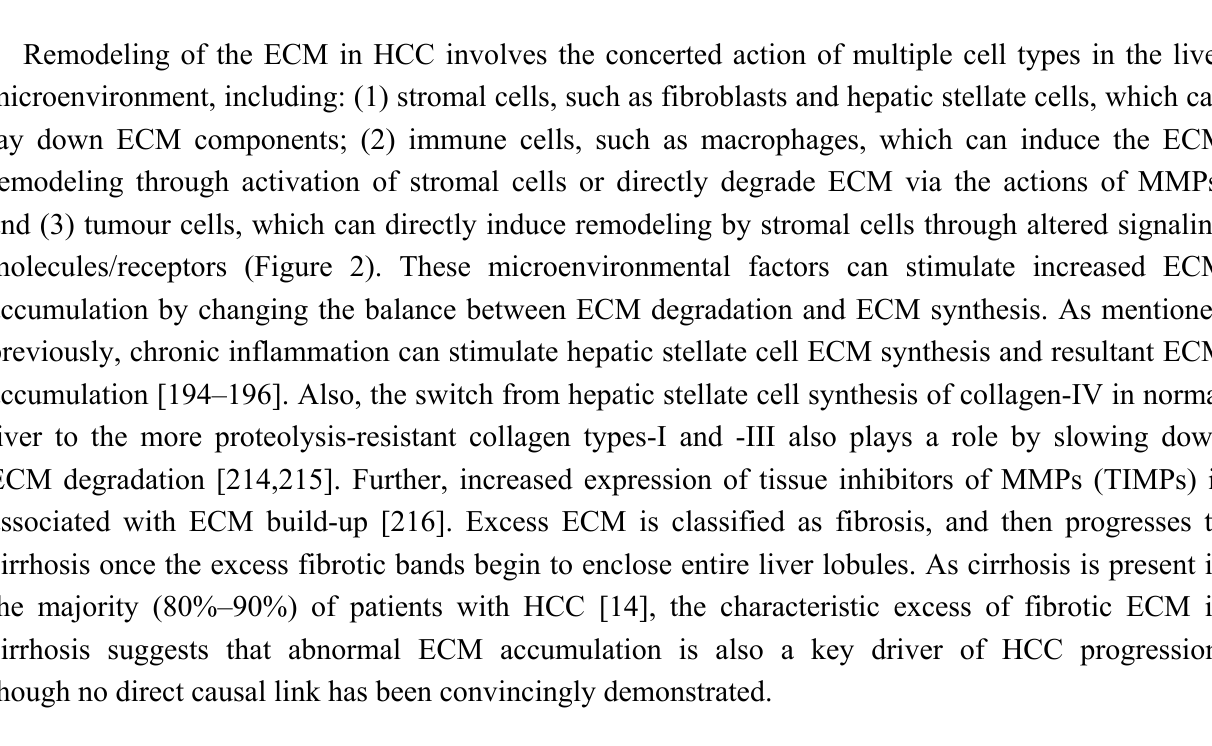
Figure 2. A schematic diagram of interactions between the ECM and cells in the liver